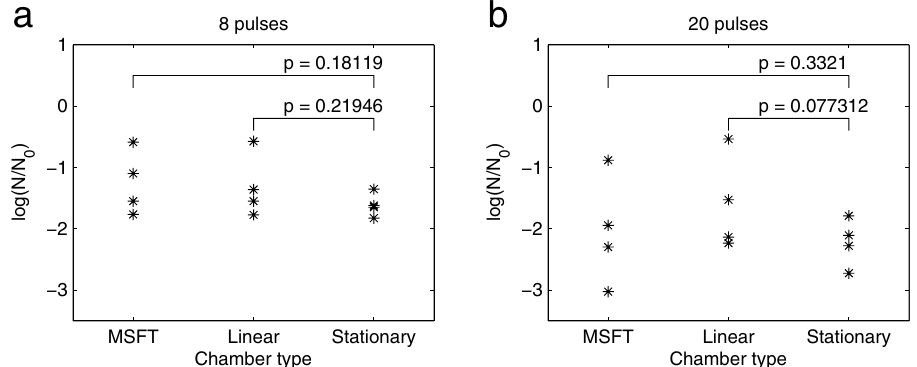
Figure 7. Inactivation of bacteria E. coli in three different electroporation chambers. Stacionary and two flow- through chambers: new colinear (MSFT) and linear with parallel plate electrodes. Number of pulses was ( a ) 8 pulses or ( b ) 20 pulses. Inactivation of E. coli is expressed as a log 10 inactivation. Bacterial cells were exposed to rectangular electric pulses with the duration 100 µ s, repetition frequency 10 Hz and electric pulse amplitude 15 kV/cm. Density of the treated sample was 10 7 CFU/ml, number of independent experiments n = 4.